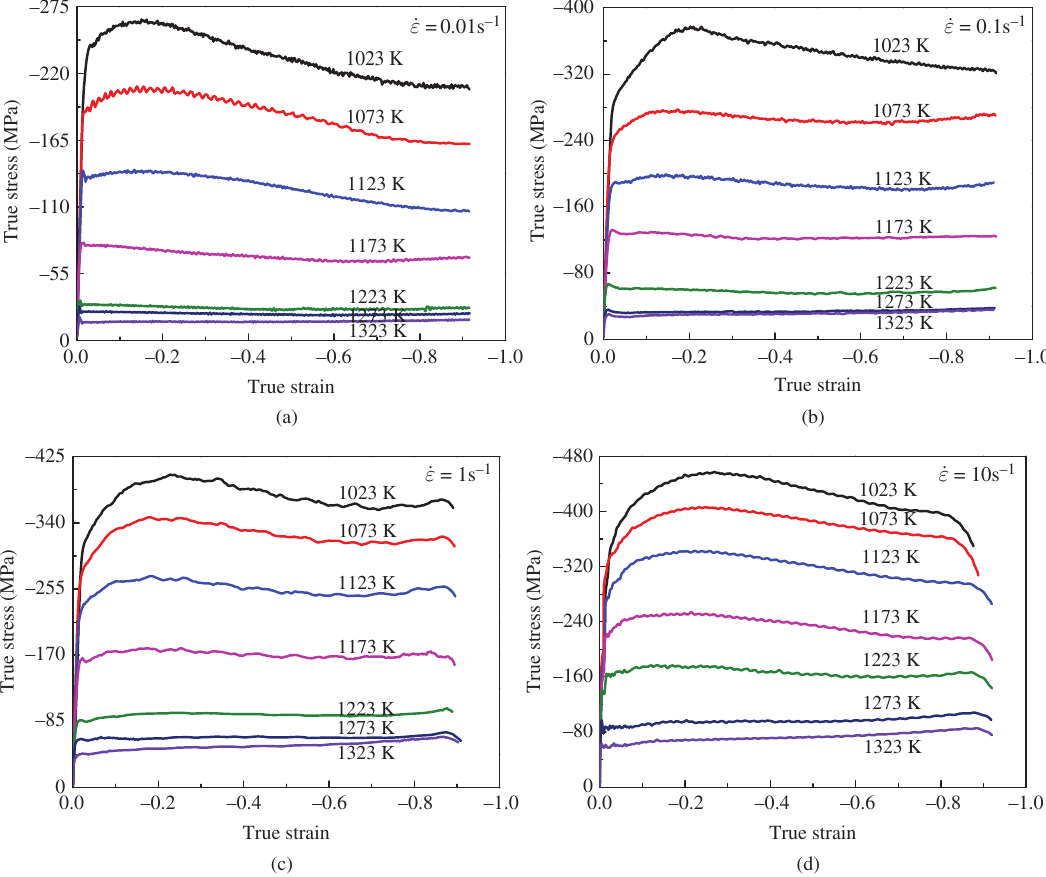
Figure 3 : True stress – strain curves of Ti – 6Al – 4V alloy obtained by Gleeble 3500 under the different deformation temperatures with strain rates (a) 0.01 s − 1 , (b) 0.1 s − 1 , (c) 1 s − 1 , (d) 10 s − 1